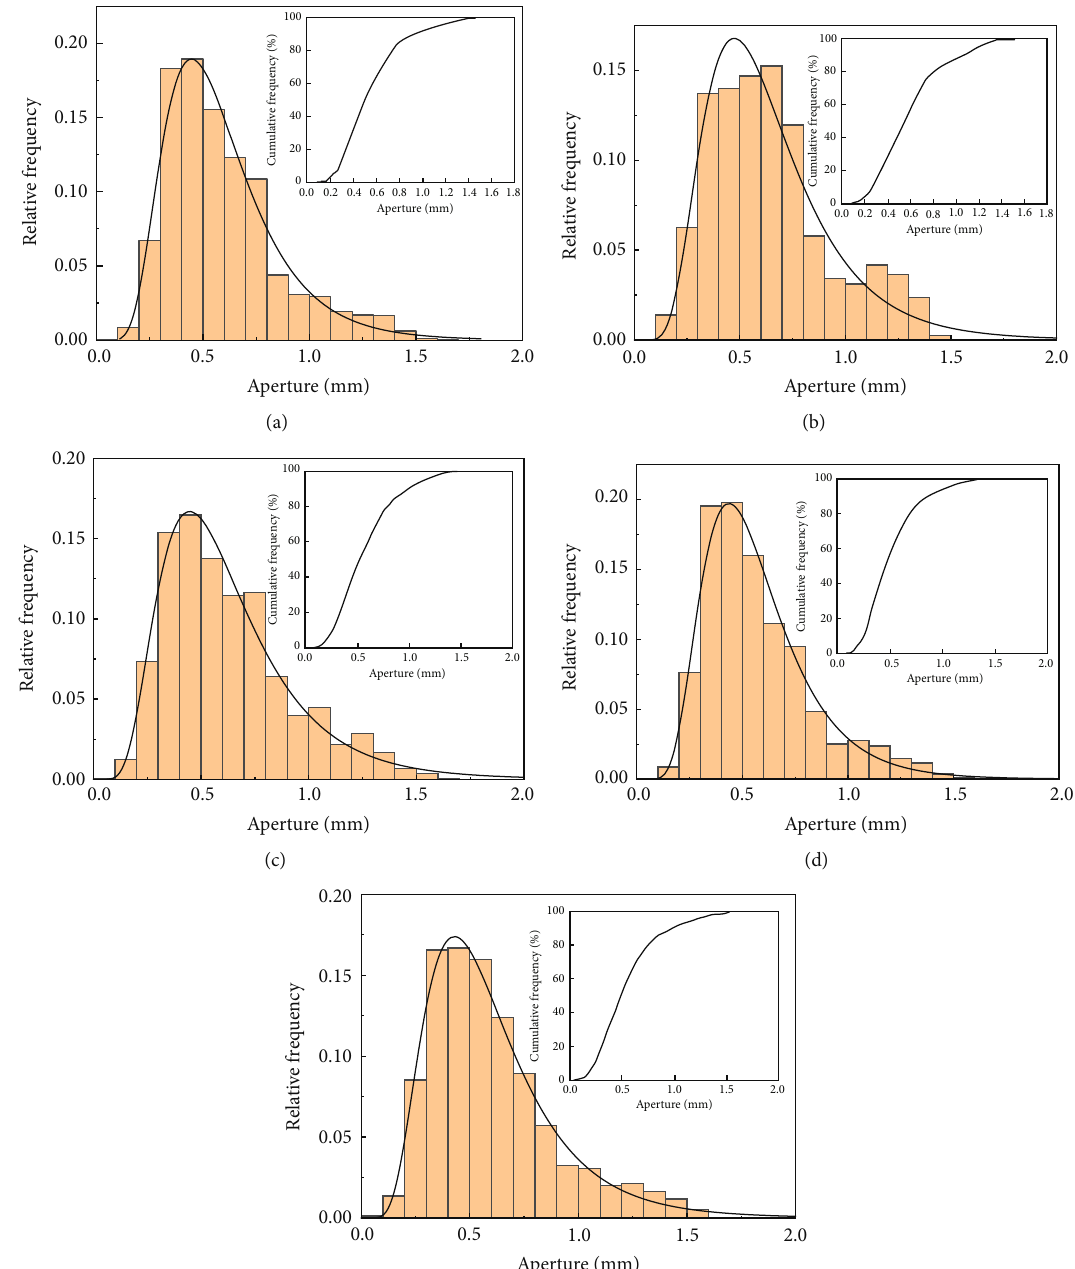
Figure 12: Statistics of aperture distribution of PCE